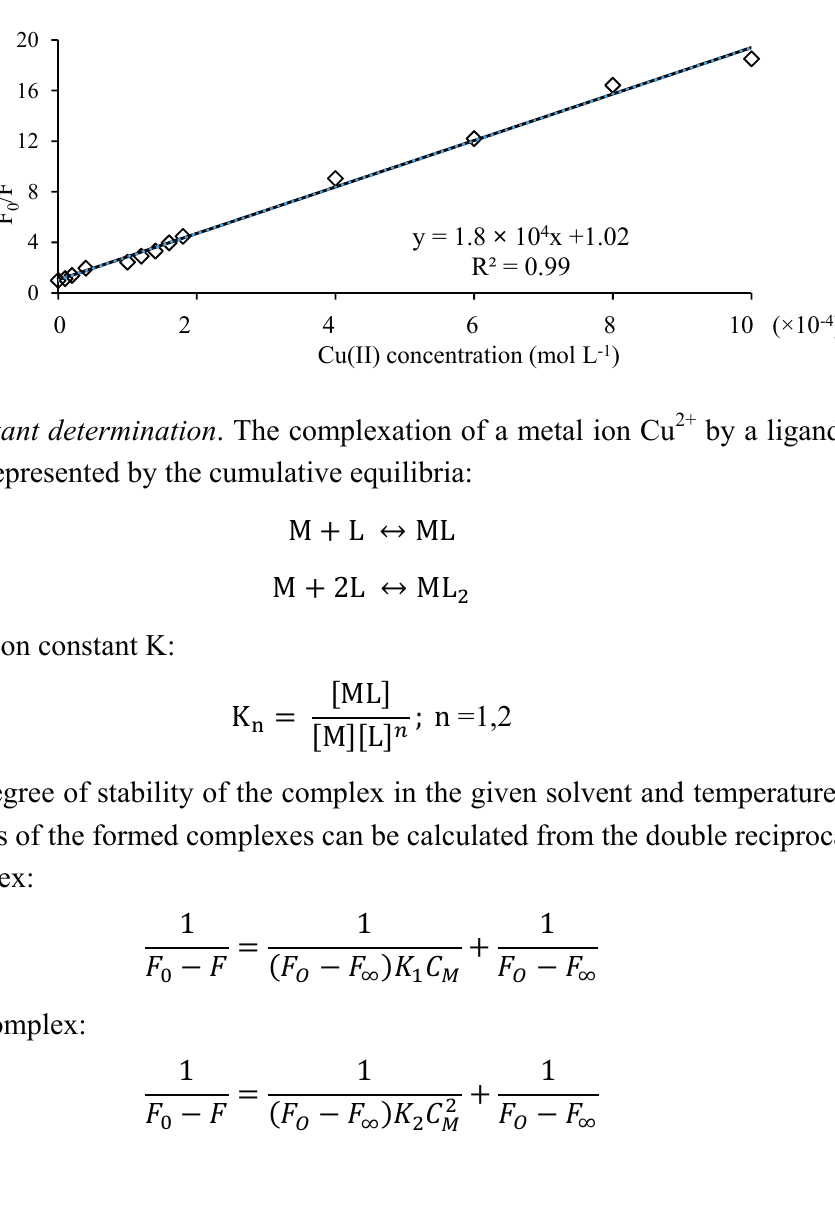
Figure 7 . Stern-Volmer plot for the quenching of levofloxacin by copper